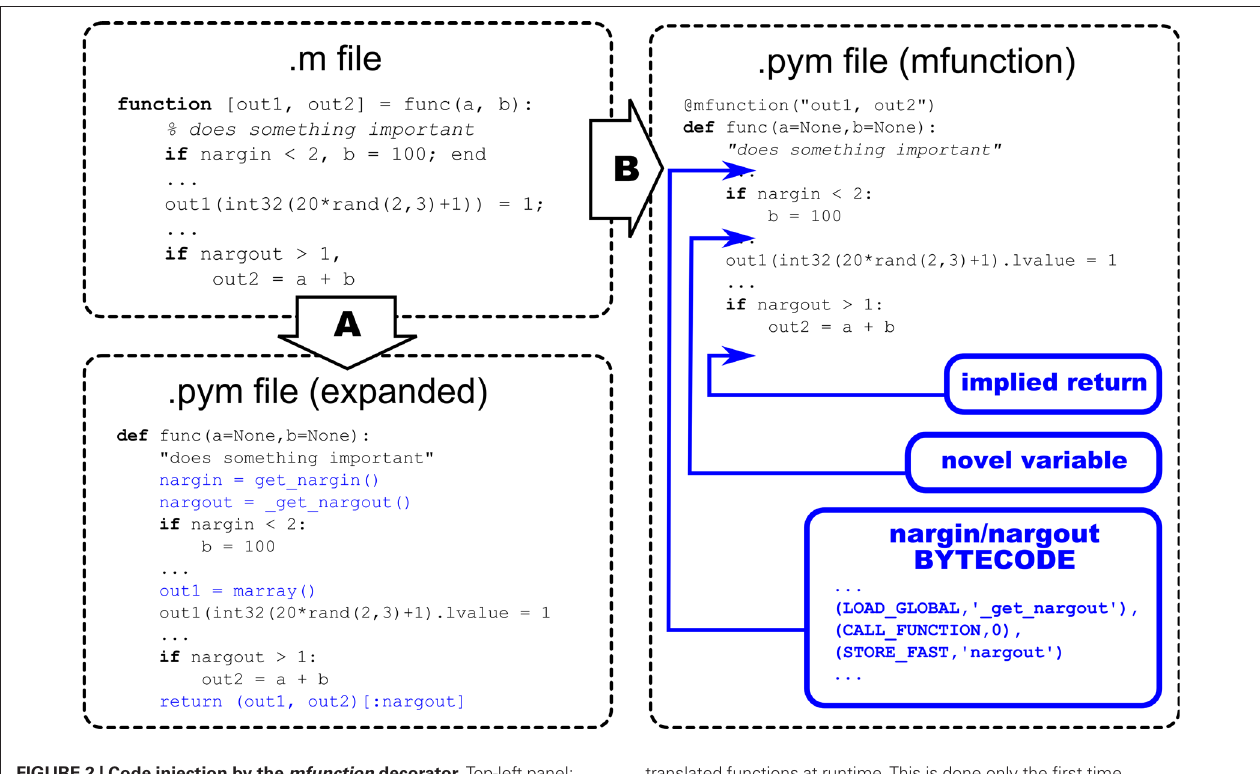
FIGURE 2 | Code injection by the mfunction decorator. Top-left panel: original MATLAB ® code; Bottom-left panel (A) : translation with added code necessary for execution in Python without mfunction ; Right panel (B) : illustration of how mfunction inserts byte-code into